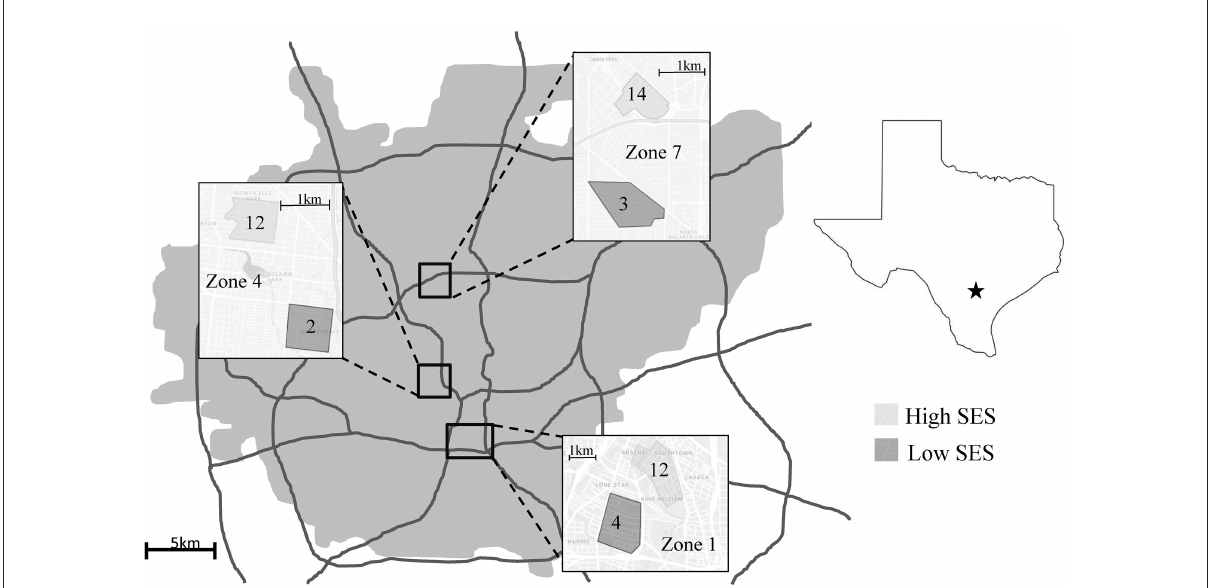
FIGURE1 Study site locations. Shaded boxes are the selected neighborhoods of different SES. Numbers inside the boxes are number of completed surveys collected. Note that three respondents are not included in this figure due to not listing their address on the on-line survey. Figure modified from (45,